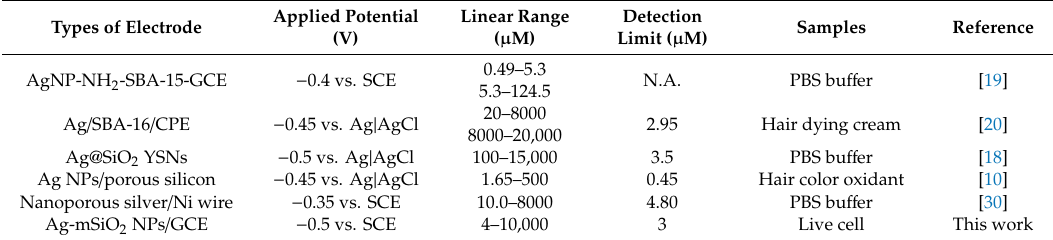
Table 1. Comparison of the present work with that reported in literature for hydrogen peroxide sensing by Ag NP impregnated silica NPs.